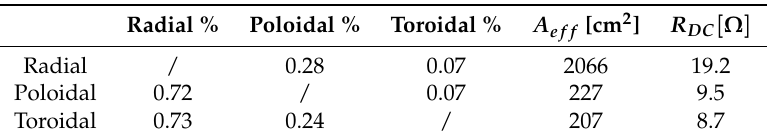
Table 1. Cross-talk percentage, effective area and DC resistance measured for the three radial, poloidal and toroidal windings of the probe prototype.